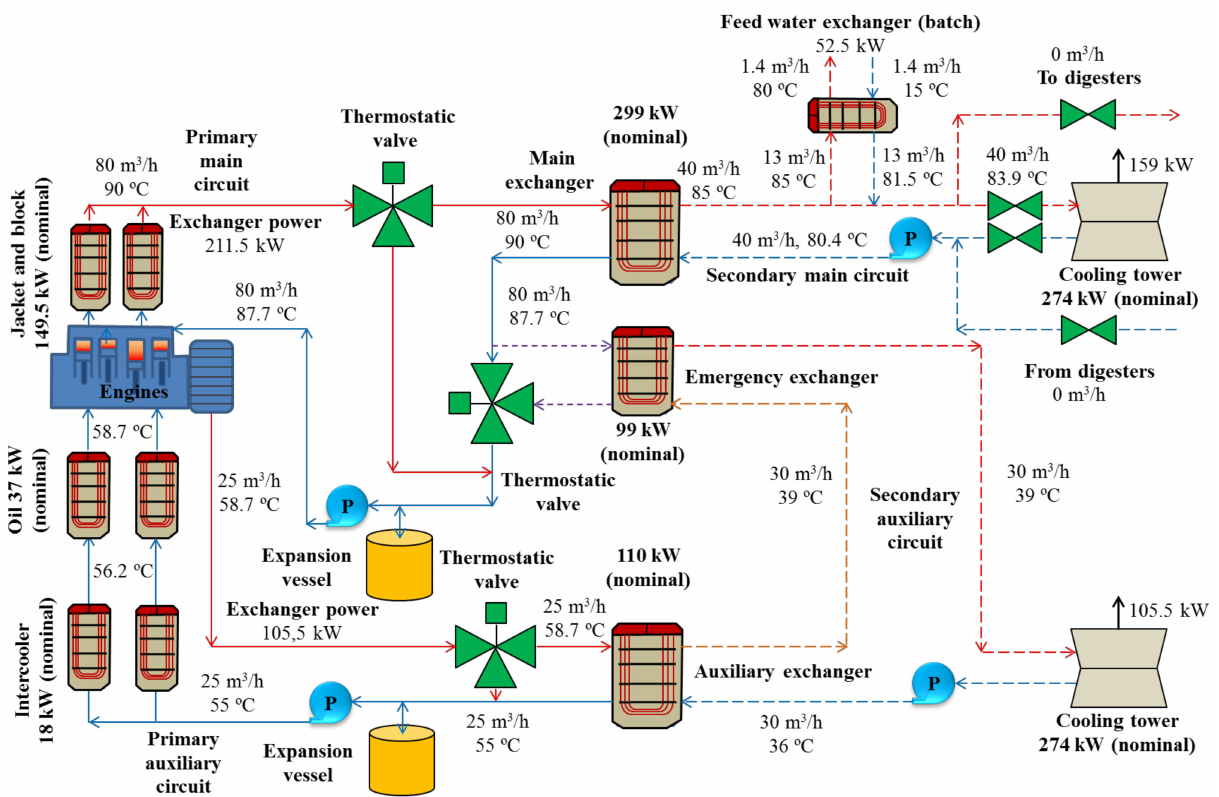
Figure 7. Mass and energy balance of the engine cooling circuits at the operating